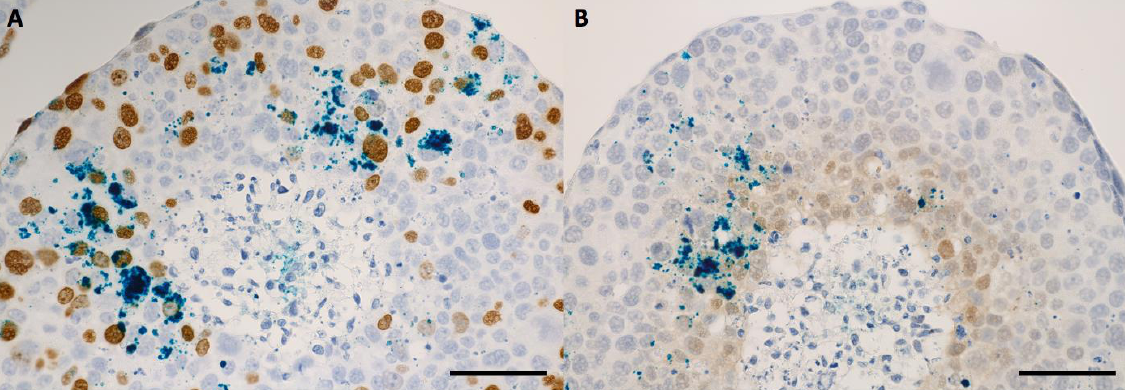
Figure 7. Bright-field microscopy images — details of FaDu spheroid sections that were previously incubated for 48 h with 200 μg/mL IONP DOX ; immunohistochemical staining of proliferative areas using bromodeoxyuridine ( A ), and of hypoxic areas using pimonidazol ( B ); light blue hematoxylin, dark blue IONP, dark brown proliferative cells, light brown hypoxic cells; measure bar is 50 μ m.